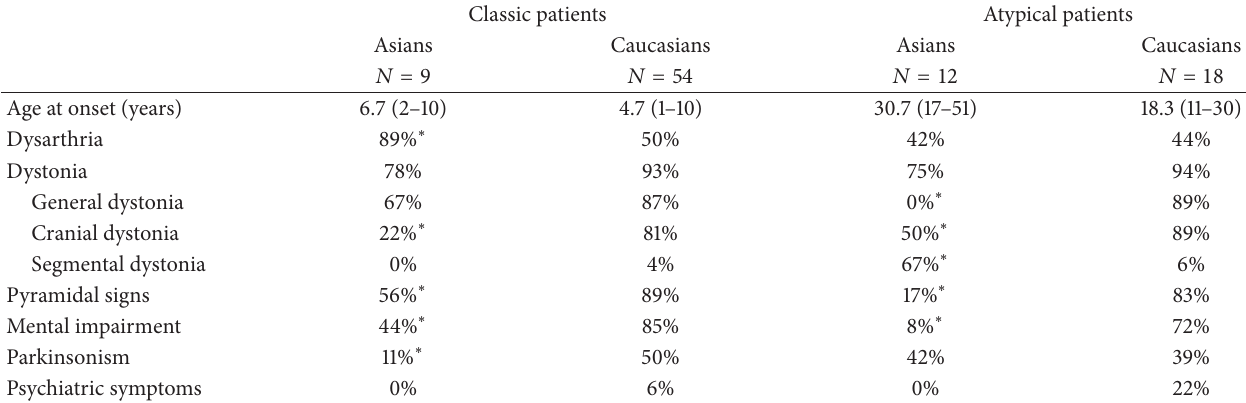
Table 3: Clinical findings in patients with PKAN: Asians versus Caucasians.